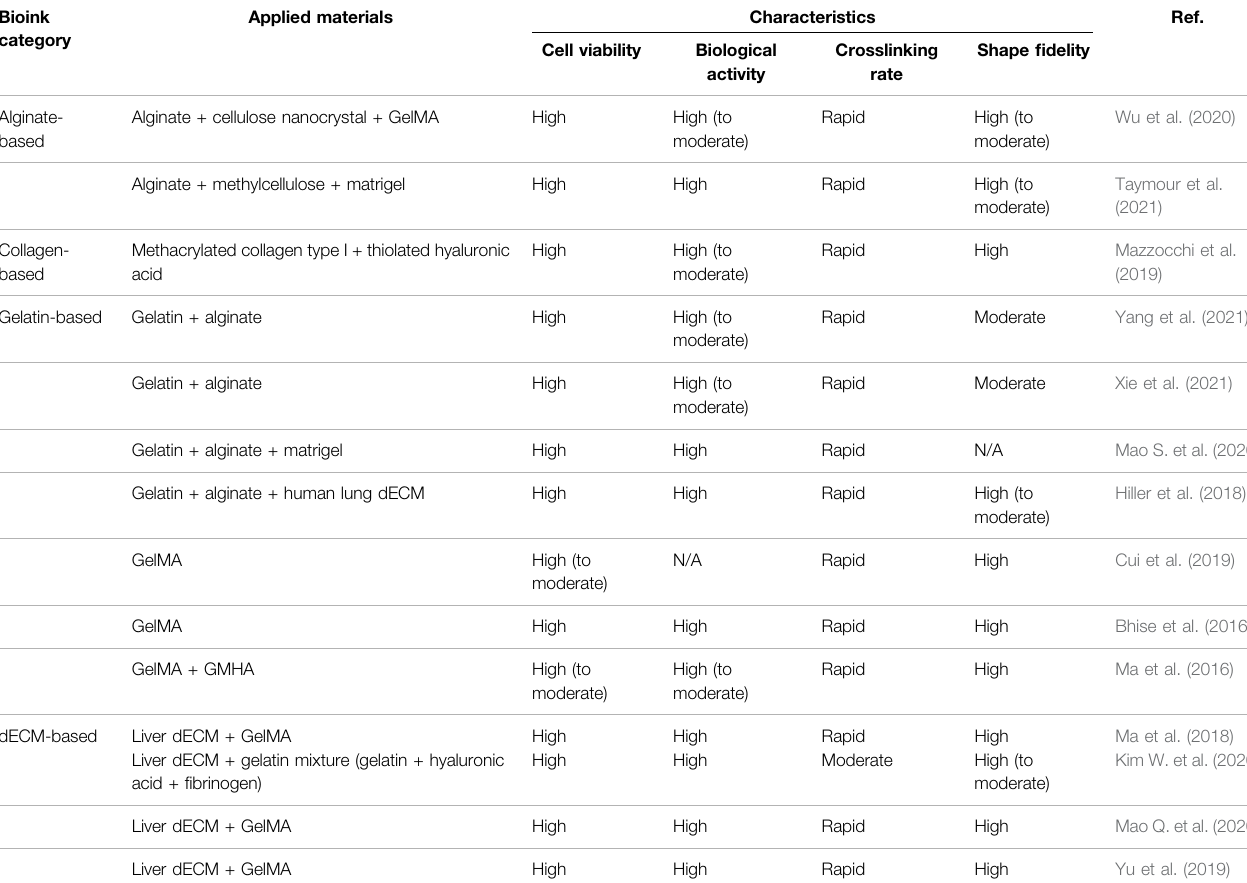
TABLE 1 | Summary of multicomponent bioinks based on different natural biomaterials for 3D bioprinting liver tissue. Bioink category